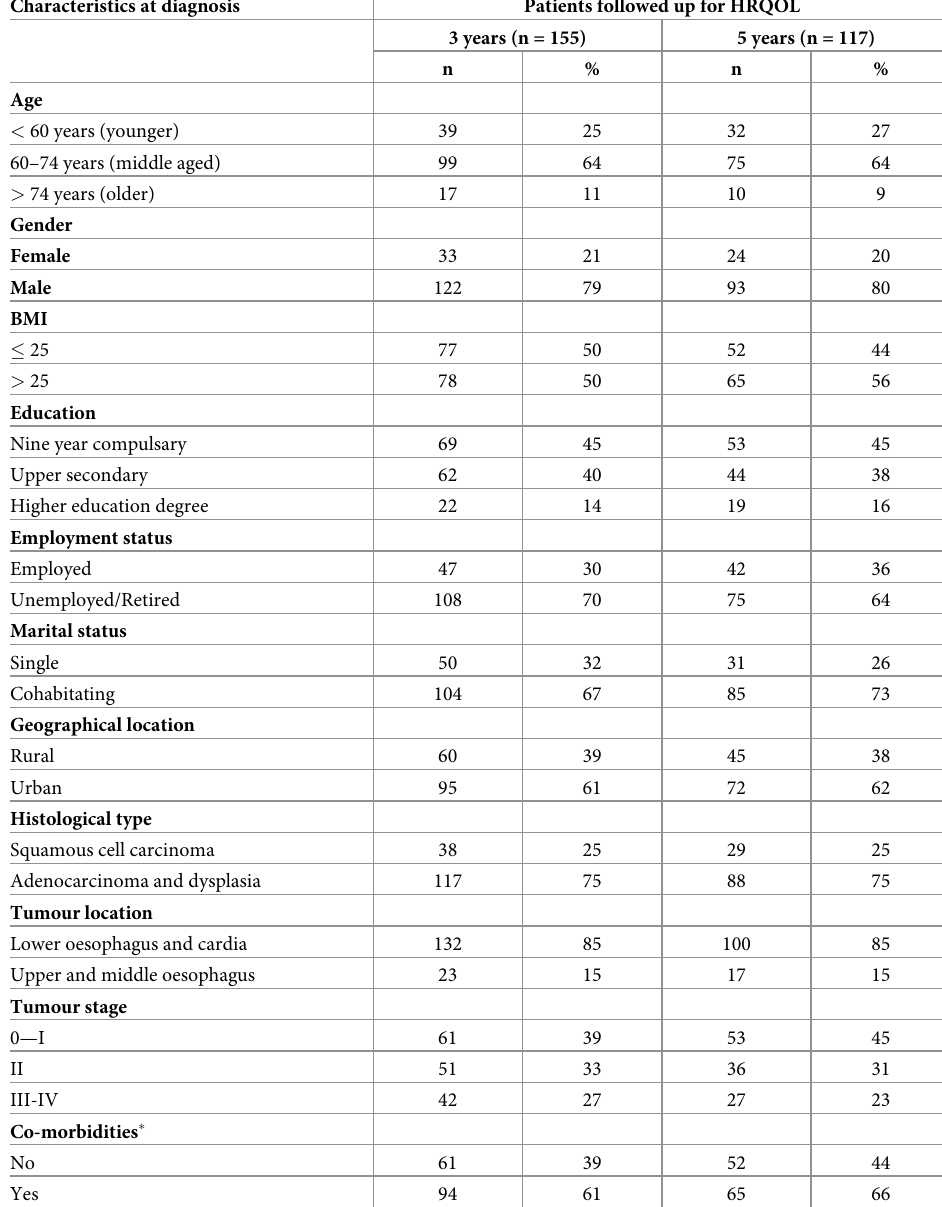
Table 1. Characteristics at diagnosis of patients who responded to HRQOL questionnaires at 3 years and 5 years following surgery for oesophageal cancer. Characteristics at diagnosis Patients followed up for